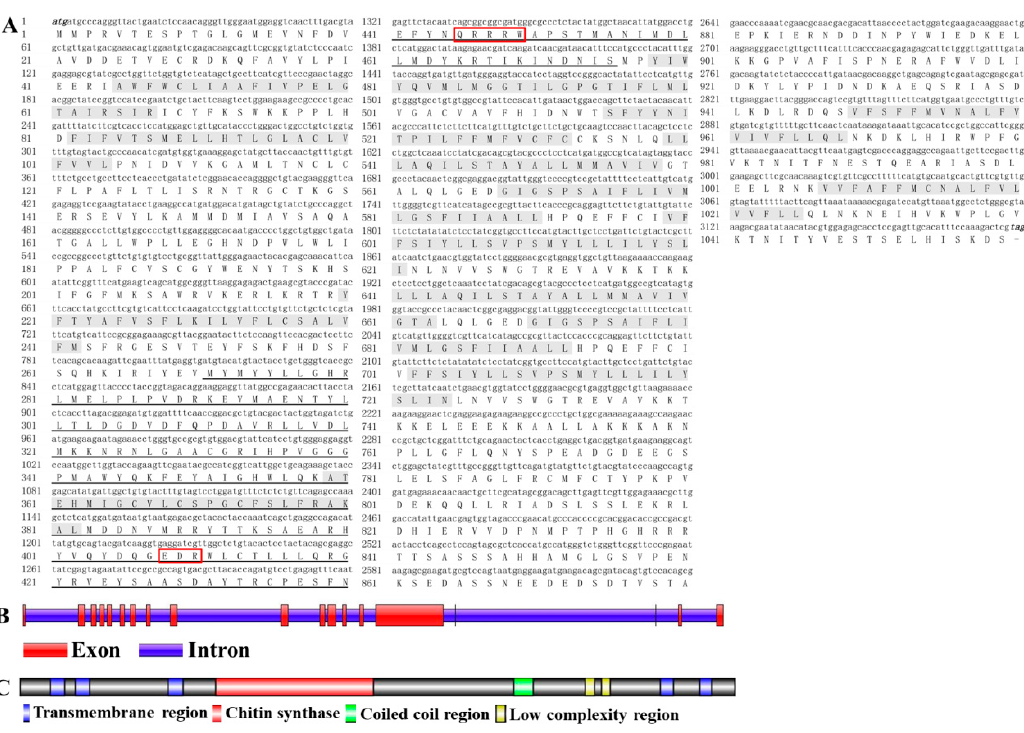
Figure 1. Bioinformatics analysis of Diaphorina citri chitin synthase ( DcCHS ). ( A ) Complete nucleotide and deduced amino acid sequence of the DcCHS cDNA. Numbers on the left side represent nucleotide and amino acid positions. The initiation codon (ATG) and termination codon (TAG) are indicated in black italics. The Chitin_synth_2 domain is indicated in a single line. ( B ) Gene structure analysis of DcCHS by using Splign online software. ( C ) Domain analysis of DcCHS by Illustrator for Biological Sequences (IBS) software.